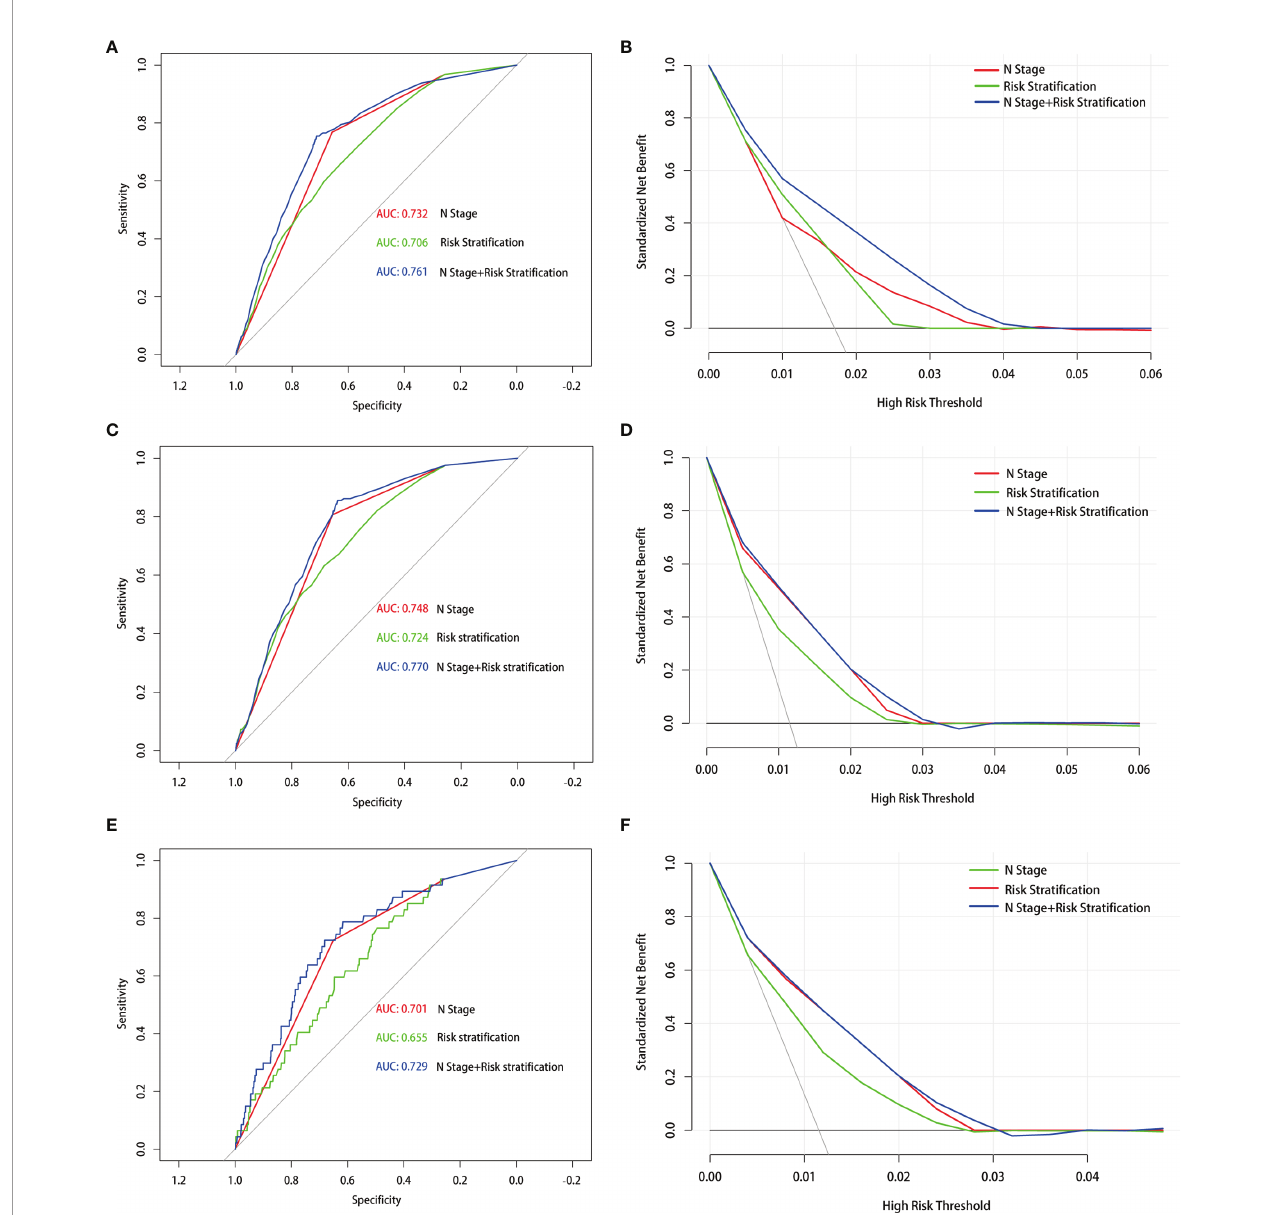
FIGURE 2 | Receiver operating characteristic and decision curve analysis curves with different models in the prediction of distant metastasis (A, B) , lung metastasis (C, D) and bone metastasis (E, F) in papillary thyroid carcinoma patients with 5 or more lymph nodes